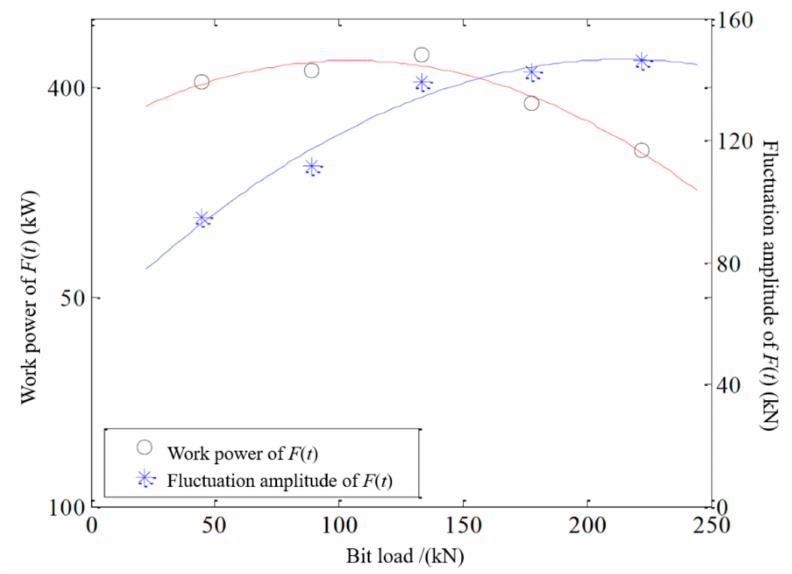
Figure 22. The variation of work power and fluctuation amplitude of F ( t ) with bit load.